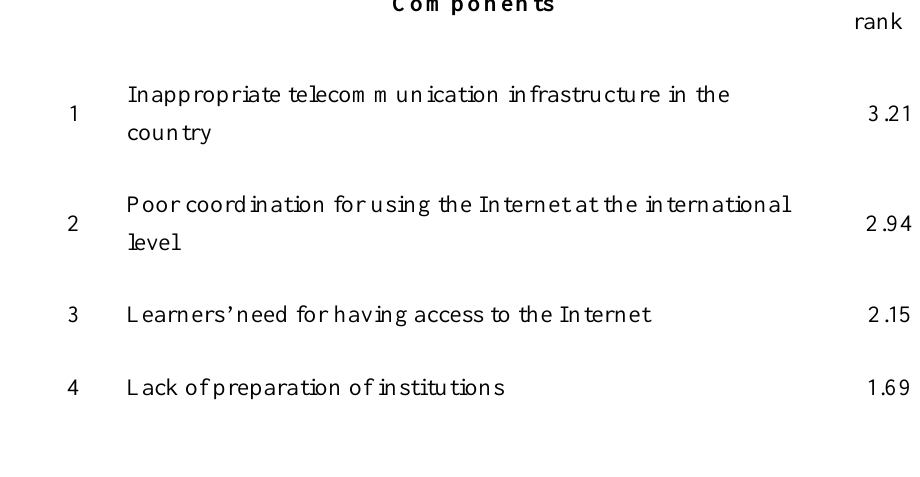
Ranking of the Four Components within the Structural Obstacle